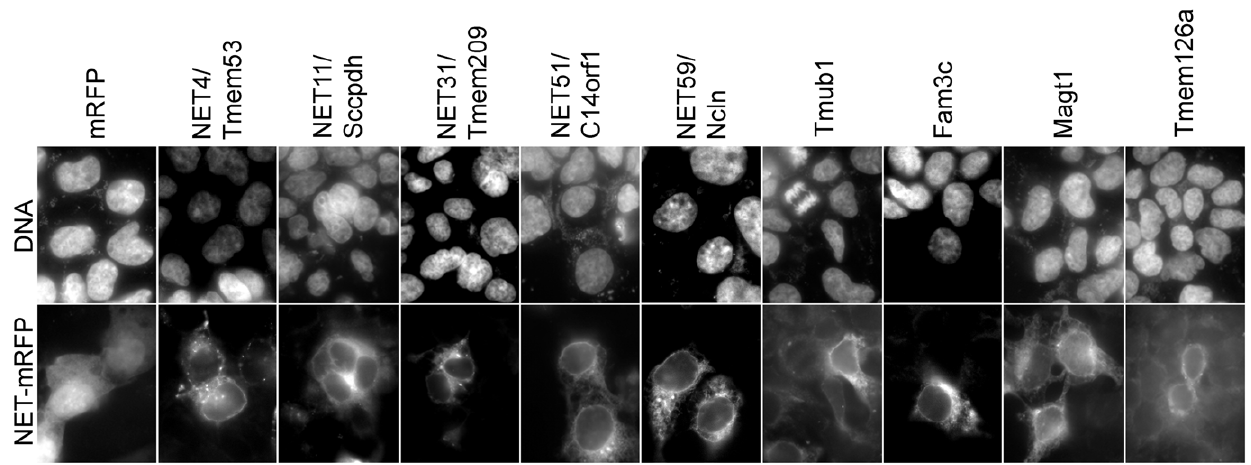
Figure 2. The changes in flow cytometry profile of cells expressing NETs are not caused by aberrant nuclear morphology of cells. Images of HEK293T cells expressing NET-mRFP shows nuclear morphology depicted by DAPI staining (upper panel) compared to mRFP signal (lower panel) indicating cells expressing NETs. doi:10.1371/journal.pone.0018762.g002 PLoS ONE |